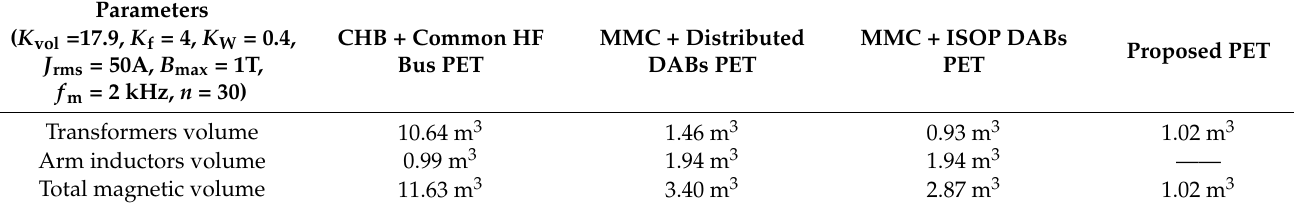
Table 2. Magnetic volume comparison of proposed PET with existing typical PETs.